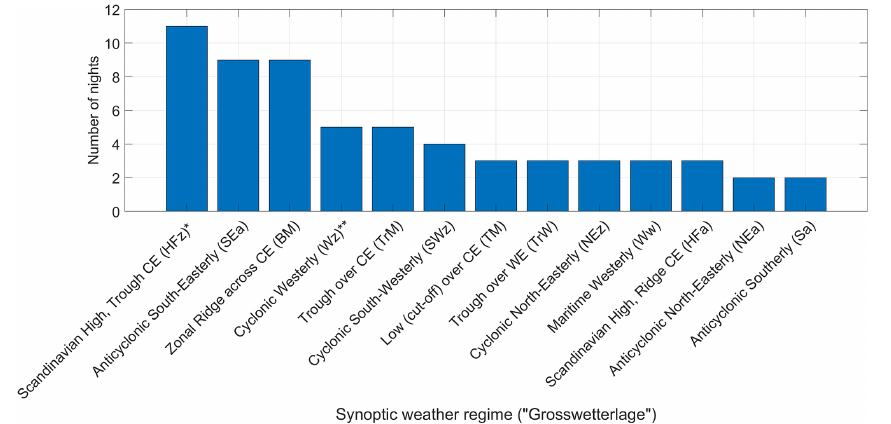
Figure 13. Number of nights with NLLJs over Falkenberg as a function of the European synoptic weather patterns ( Großwetterlagen , see James, 2007). Legend: CE = central Europe; WE = western Europe. ∗ Largest amount of long events. ∗∗ Largest amount of short events.